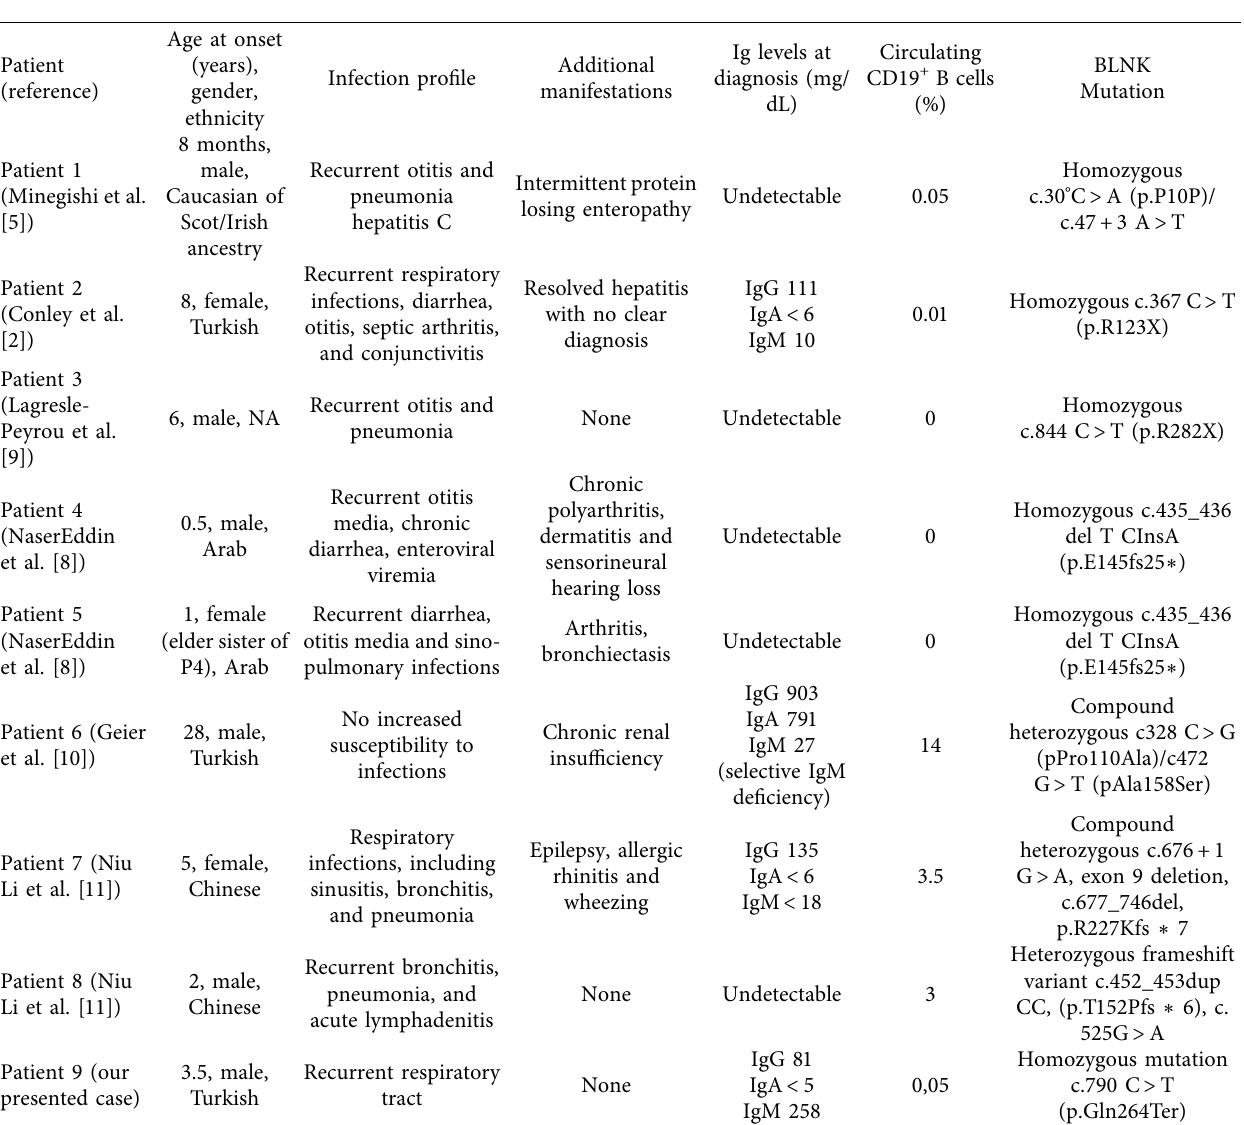
Table 2: Reported patients with BLNK protein